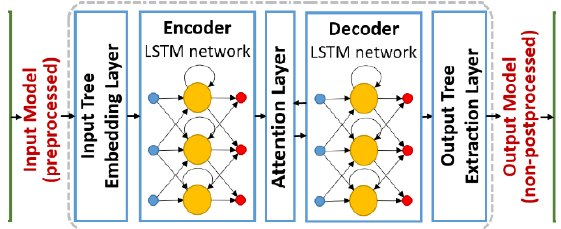
Figure 2. Encoder-Decoder with Column Attention Architecture